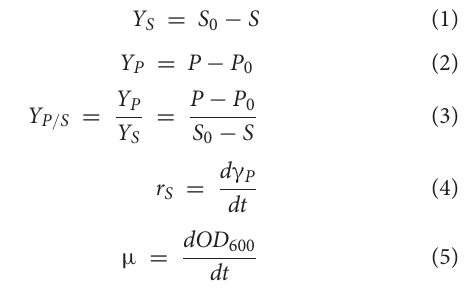
TABLE 2 | Carbon source concentrations in different media with pretreated BSG